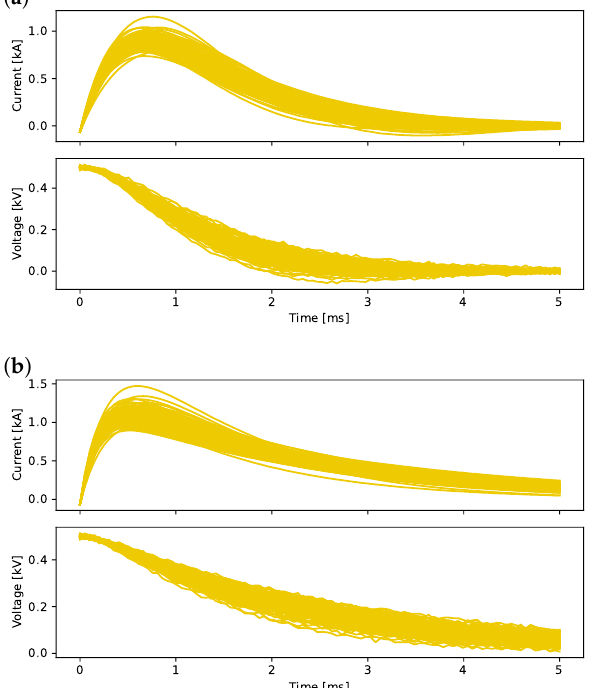
Figure 3. For algorithm verification we have used simulations of initial stages (5 ms) of faults of VSC DC cables. We have selected a set of parameters, which was then randomized with normal distribution with standard deviation equal to 10% of given parameter. Then we have simulated both currents and voltages. Subfigure ( a ) describes the pole-to-pole faults and ( b ) pole to ground